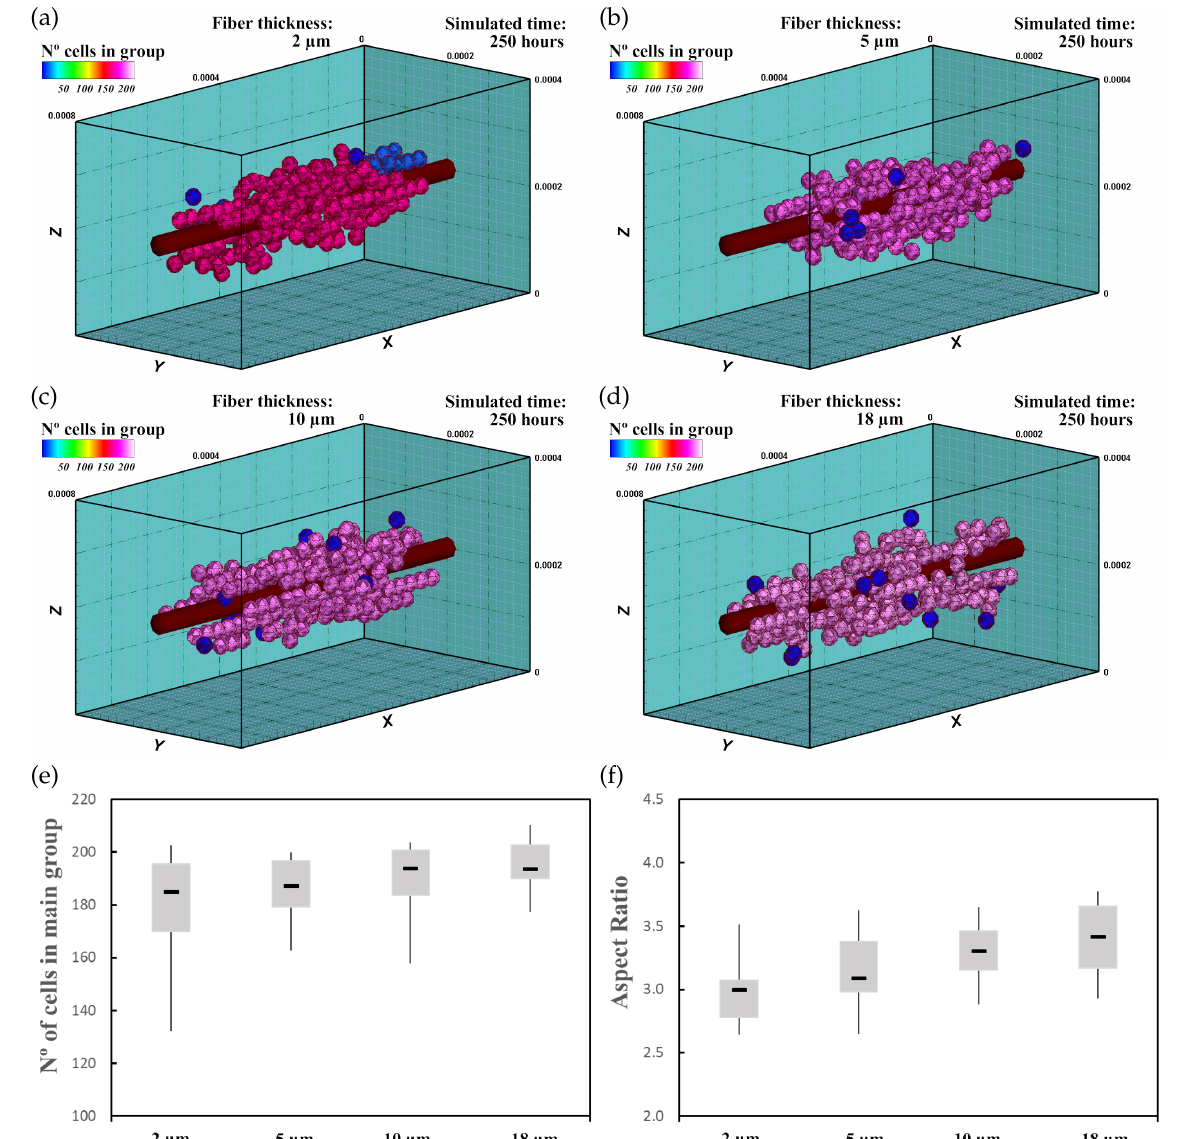
Figure 10. Group morphology and number of cells corresponding to an ECM with a central fiber thickness of 2 µ m ( a ), 5 µ m ( b ), 10 µ m ( c ), and 18 µ m ( d ). PZE fiber generates an electric field in the range of 50–200 V m − 1 , which depends on the fiber thickness. The mechanical and electrical combined effect induces faster cell migration towards the central fiber where cell proliferation increases. After 250 h, cells form an elongated group around the central fiber (see also Supplementary Material: S4). ( e ) Numerical results of the number of cells in the main group. ( f ) AR of the main